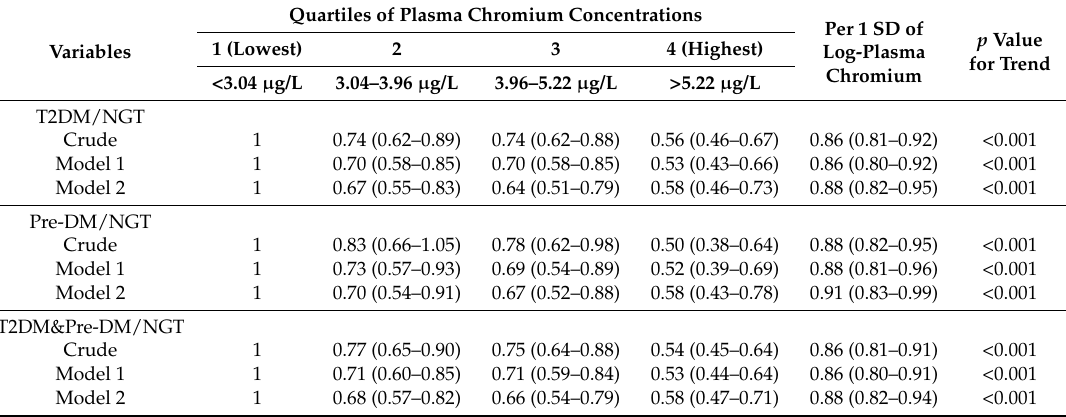
Table 2. Association of plasma chromium concentrations with T2DM and pre-DM.